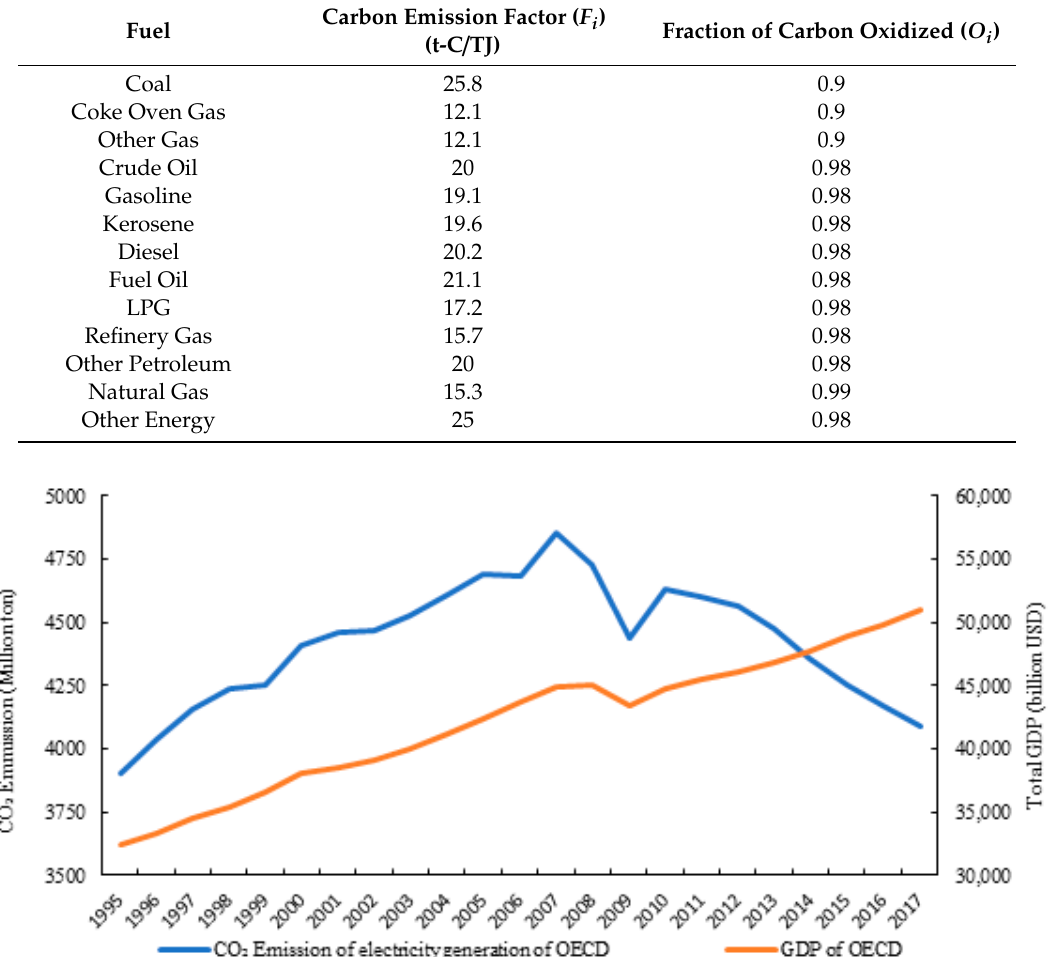
Table 1. Carbon emission factors and fraction of carbon oxidized by fuels [1].